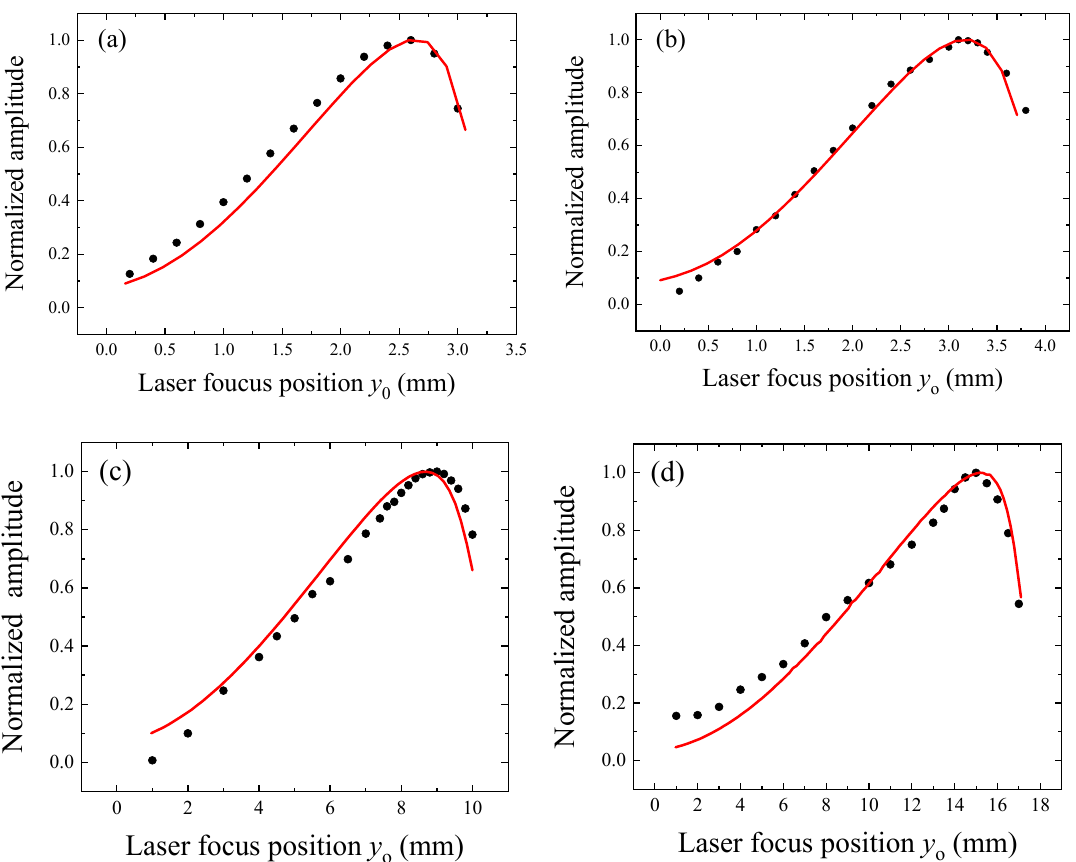
Figure 4. ( a – d ) Normalized QEPAS signal amplitudes as the function of laser focus position y 0 measured for QTFs #1 (panel a), #2 (panel b), #3 (panel c), and #4 (panel d). Black dots represent the experimental data and the red lines represent the theoretical curve calculated by the numerical method. Table 3. Comparison of theoretical estimation of optimum laser position given by the numerical model reported in Reference [7] and results obtained